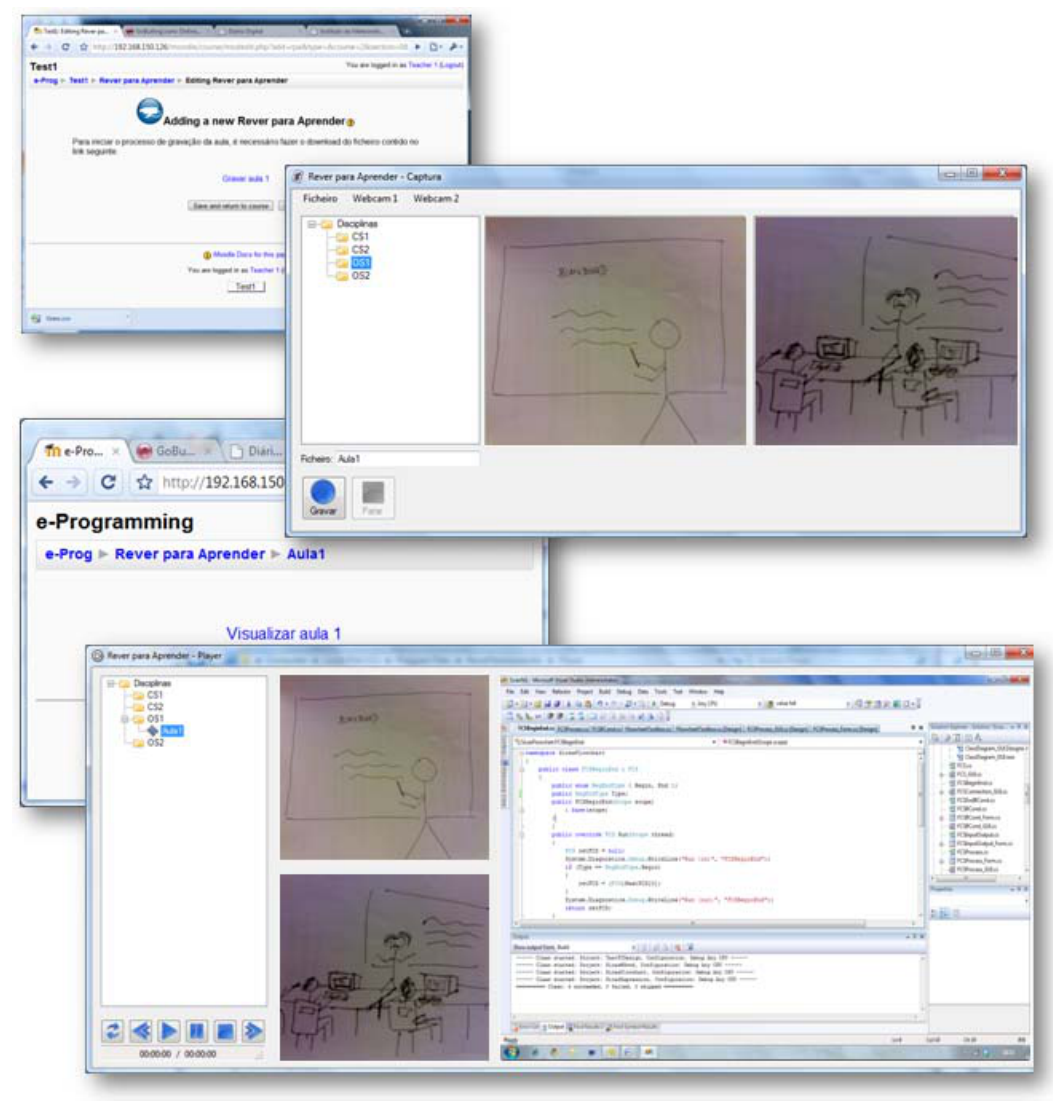
Figure 8. Lesson recording and